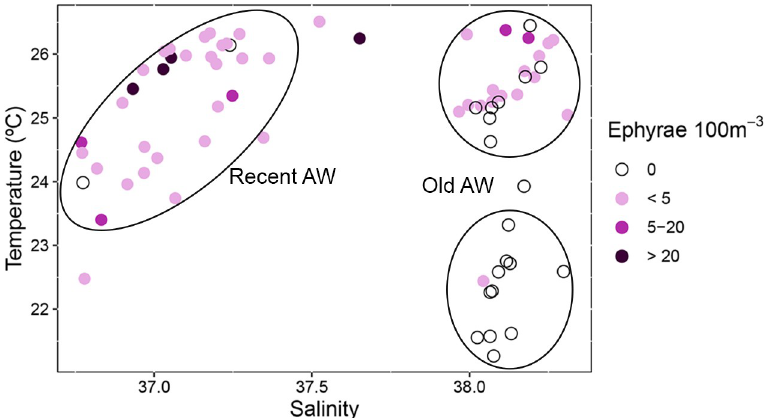
Fig 8. Depth-integrated ephyrae abundances in relation to mean surface (5–10 m depth) salinity and temperature at plankton stations.